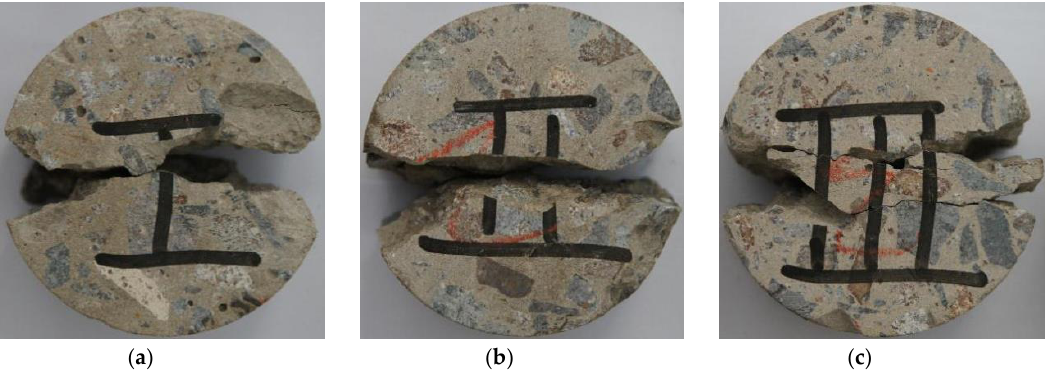
Figure 5. Schematics of substantial damage and missing edge details under impact velocity v = 11.37 m/s: ( a ) Concrete series I; ( b ) Concrete series II; ( c ) Concrete series III.